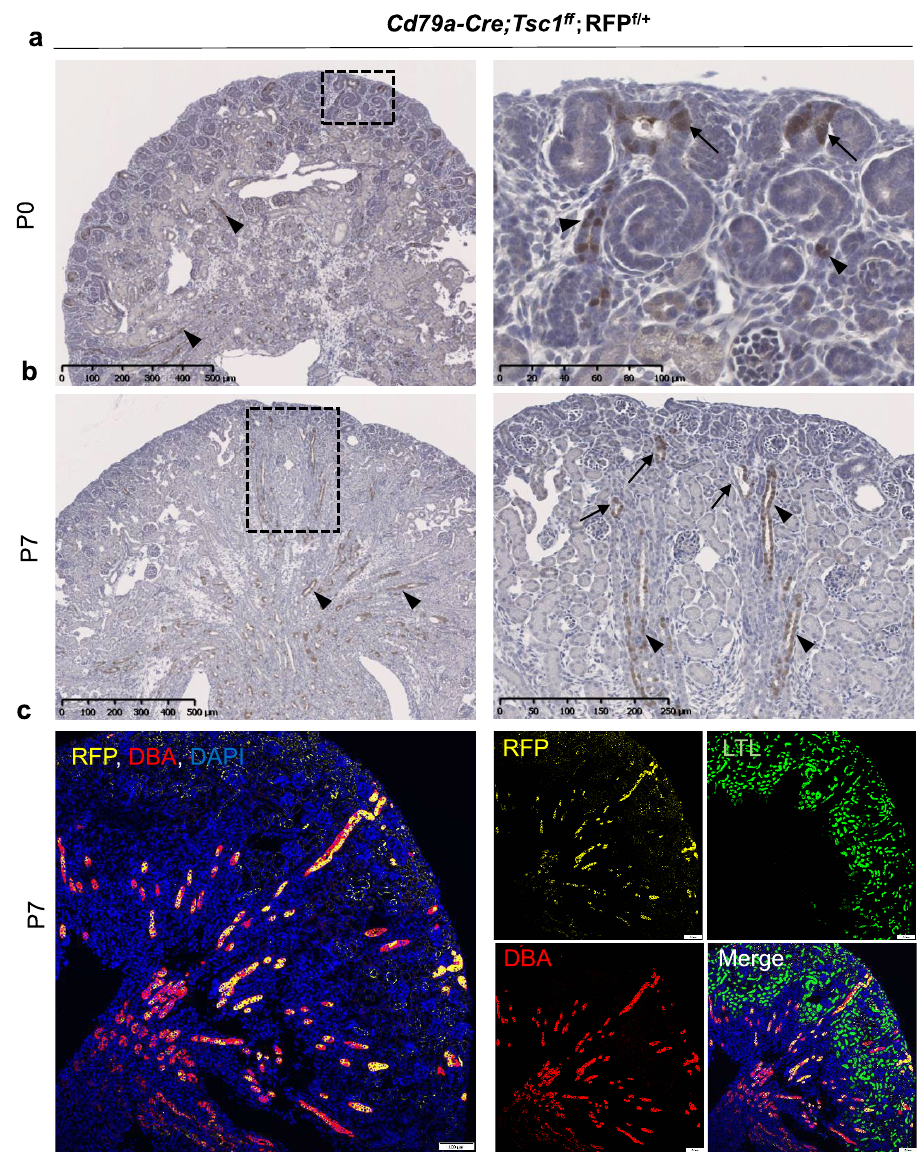
Figure 4. Localization of Cd79a-Cre activity in developing tubules of red fluorescent protein (RFP) reporter mice. Renal phenotypes of Cd79a-Cre;Tsc1ff.;RFP f/ + mice are shown. The RFP reporter traces cell lineage, and the Cd79a promoter drives Cre recombination. ( a ) Immunohistochemistry staining of kidney sections at postnatal day (P) 0, the RFP signal is found along the ureteric bud tip and stalk in the superficial nephrogenic cortex (arrows) and in the developing distal tubules of the medulla (arrowheads). ( b ) At P7, RFP signals extend over the medulla along the collecting ducts (arrowheads), in addition to being expressed in the distal convoluted tubules of the superficial cortex (arrows). ( c ) Immunofluorescence staining of kidney sections at P7 with an anti- RPF antibody as well as markers for proximal tubules (LTL, green) and distal tubules and collecting ducts (DBA, red). RFP signals mostly colocalized with DBA, indicating that the Cd79a promoter is active in ureteric buds and their progenitors in developing distal nephrons. Inset: Dashed box areas are